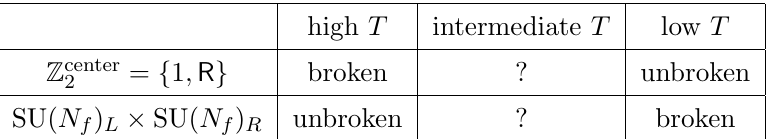
T max( T chiral ; T center ). (cid:20) (cid:20)